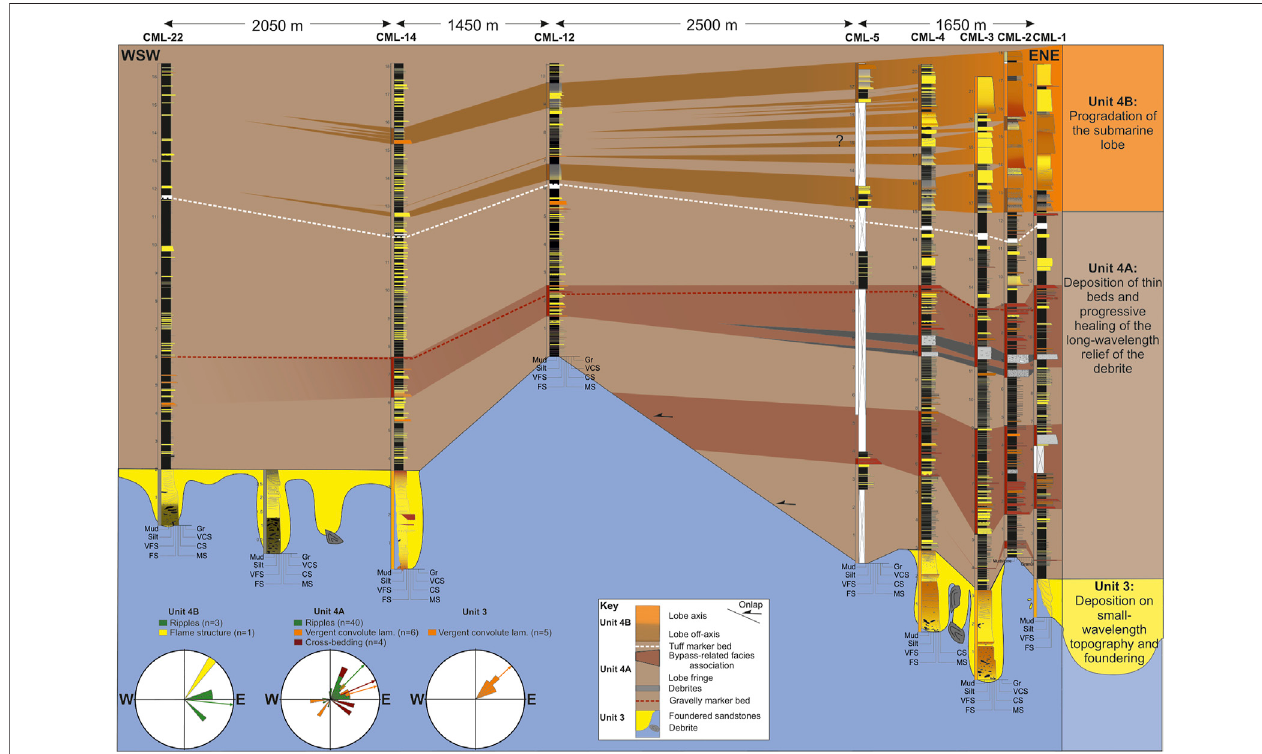
FIGURE 8 | Correlation panel focusing on the strata (Unit 3 and 4) overlying the debrite (Unit 2). Note the colour bar next to each log representing the facies associations(see Panel5 ).Unit3isonlypresentinwesternandeasternsectorswhilstabsentinthedebritehigh(CML-12).ThelowerpartofUnit4Athinsandonlapsthe debrite, while the upper one shows a larger lateral extent. Note the gravelly and tuff marker beds (red and white dashed lines, respectively). Unit 4A consists of an alternation between fi ne-grained lobe fringes and coarser healing lobe fringes in the western sector. Coarse-grained healing fringes pinch out, developing fi ne- grained lobe fringes in the eastern sector. Unit 4B consists of amalgamated thick-bedded sandstone of lobe axis, thinning into medium-bedded dominate lobe off-axis environmentinthewesternsector.Thesand-richlobethinsand fi nestowardstheeast,pinchingoutinthecentralsectorandinter fi ngeringwiththelobefringedepositsof Unit 4A. Note that the pinch-out terminations are developed where the debrite relief is highest. The rose diagram shows the details of ripples (green), vergent convolute lamination (orange), Flame structures (yellow) and cross-bedding (red). Mean vectors of each type are shown, all suggesting a NE trend, except in Unit 4B, where the ripples suggest an E-directed palaeo fl ow indicating de fl ection processes. The perimeter of the rose diagrams corresponds to 100% of the value.